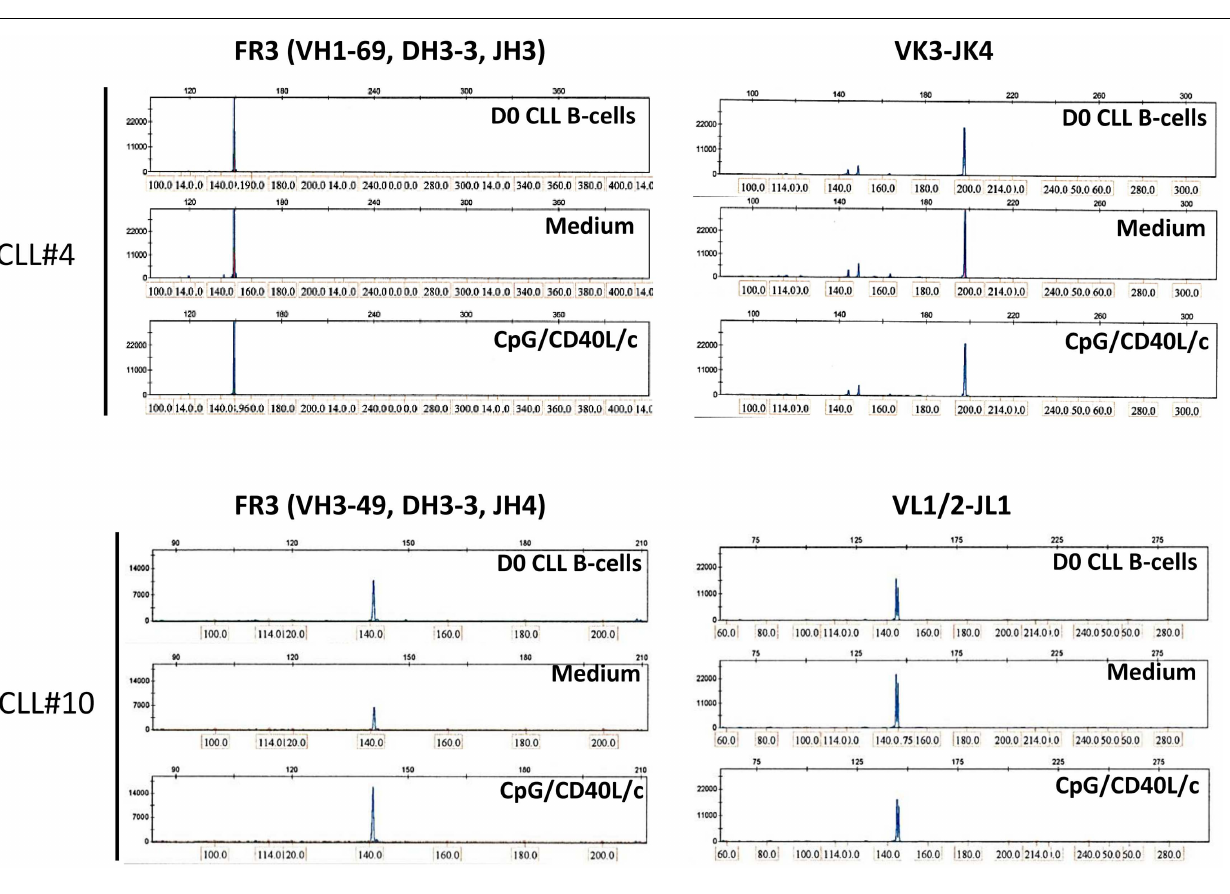
Right panels show a peak in the IgL-specific size range for D0 CLL B-cells, D7 untreated-cells (medium), and D7 CpG/CD40L/c-stimulated cells, indicating a monoclonal rearrangement.The data presented are for CLL samples #4 and #10, in which isotype-switching was detected.The data are representative of six experiments (CLL samples #3, #4, #6, #9, #10, and